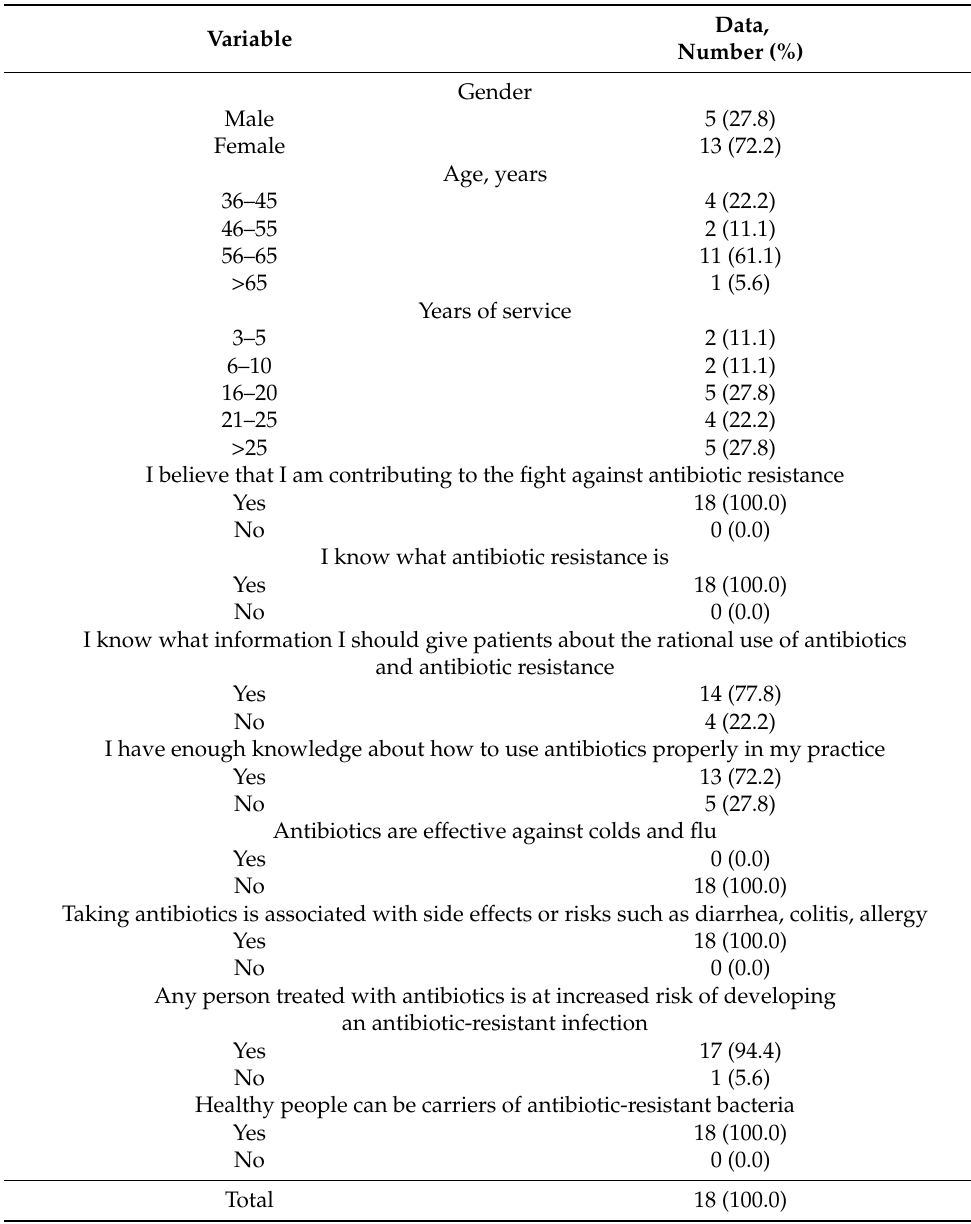
Table 2. Demographic characteristics of the pediatricians and their knowledge about antibiotics and antimicrobial resistance. Data, Variable Number (%) Gender Male 5